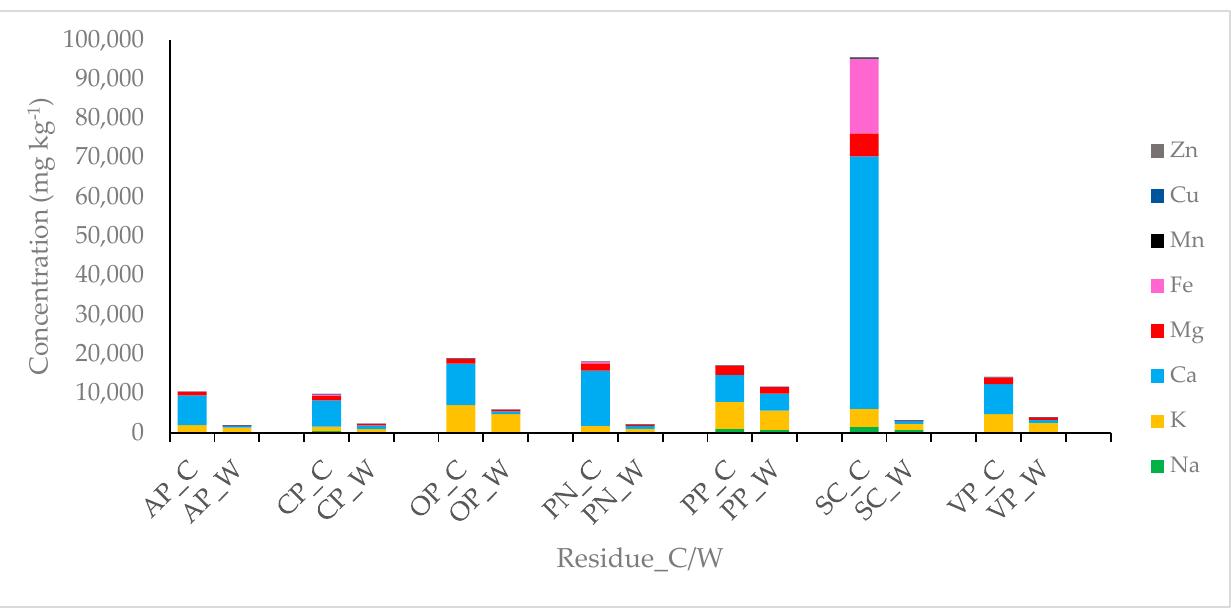
Figure 1. Total nutrient content (mg kg − 1 ) of each residue in elemental composition (C) versus aqueous extraction (W). Table 7. Solubility index (%) of each nutrient (I N